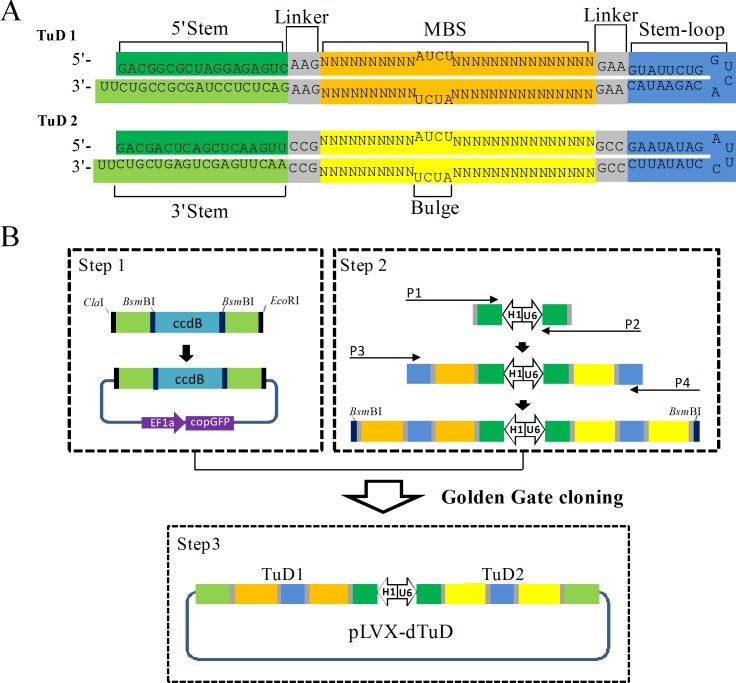
Schematic outline for the construction of pLVX-dTuD vector.
(A) Overview of a dTuD lentivirus-based vector (pLVX-dTuD) encoding two TuD RNA molecules. Each TuD RNA includes one stem (18 nt), two MBS with bulge (4 nt), one stem-loop (10 nt) and four linkers (3 nt) between stem and MBS. (B) Strategy to construct pLVX-dTuD vector. Step 1: preparation of the MBS-recipient vector. Step 2: preparation of MBS-donor by two-step PCR. Step 3: MBS-donor fragment was inserted into MBS-recipient vector by utilizing the Golden Gate cloning.